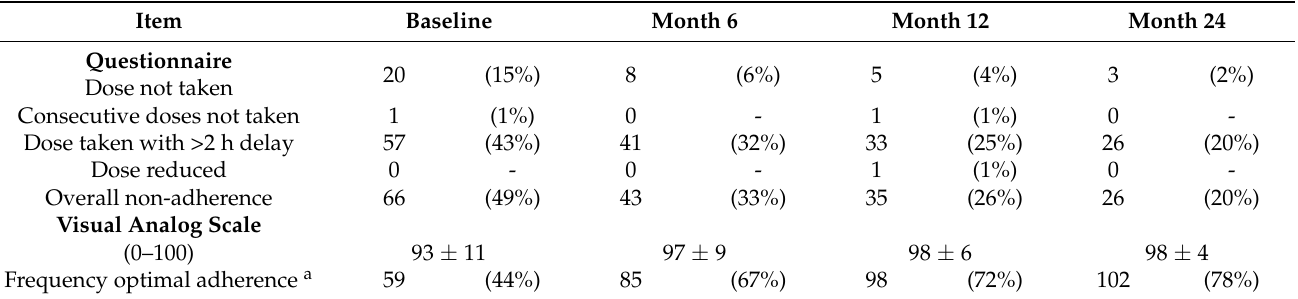
Table 2. ‘Basel assessment of Immunosuppressant Adherence Medication Scale’ (BAASIS©)–patients who completed 24-month period ( n = 134), N (%) or mean ± SD.